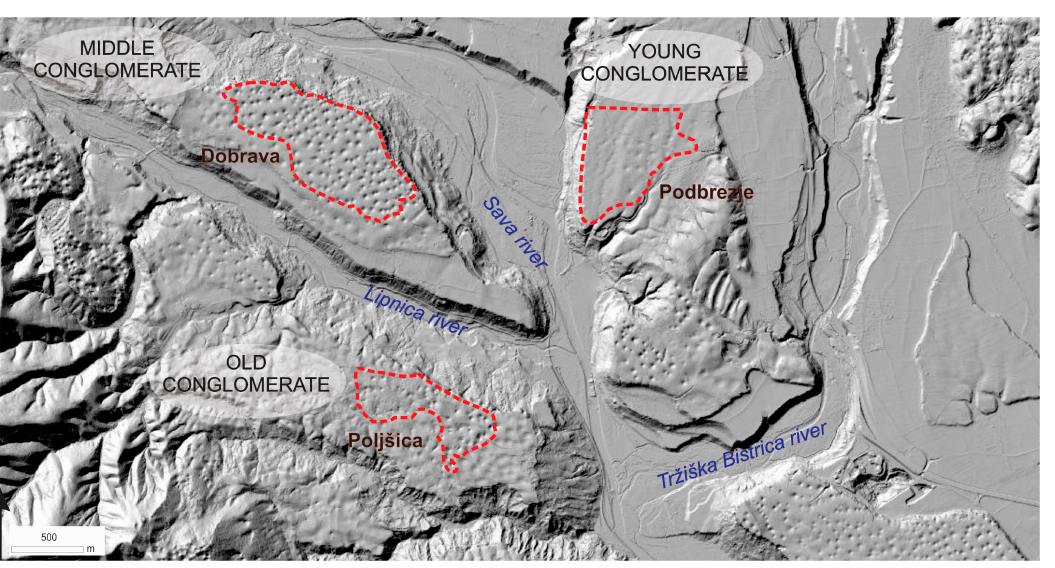
Figure 9. Test sites and relief characteristics as visible from 1 m resolution LiDAR data [37]. Table 4. Basic statistics of test sites.